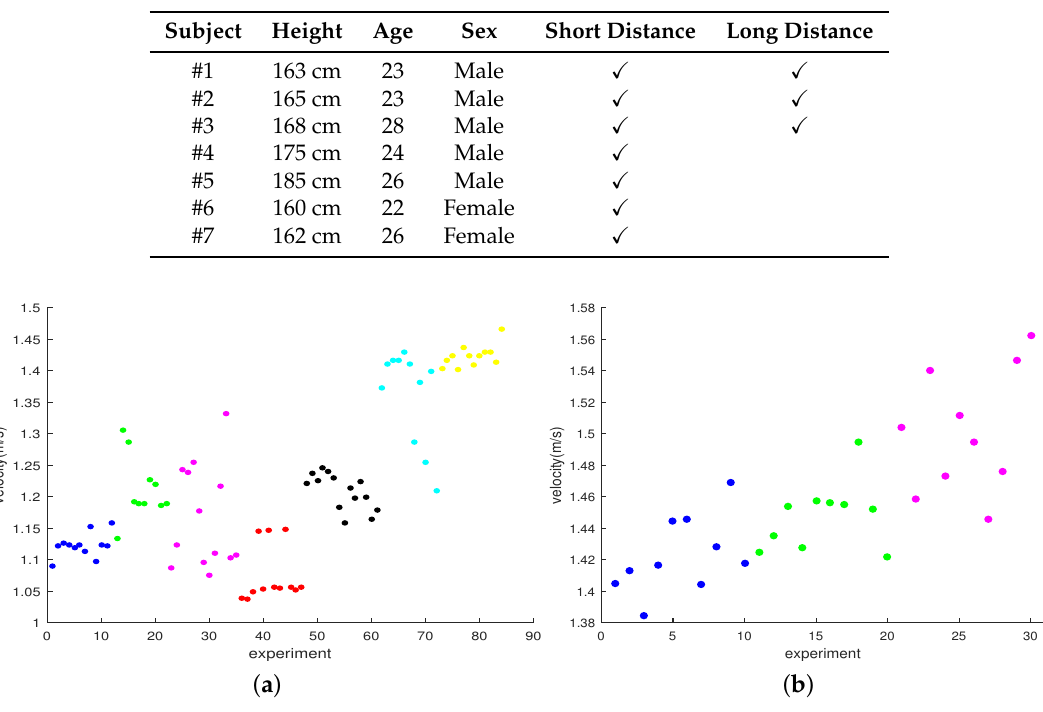
Figure 9. Gait velocities of subjects in experiments. ( a ) short distance database; ( b ) long distance